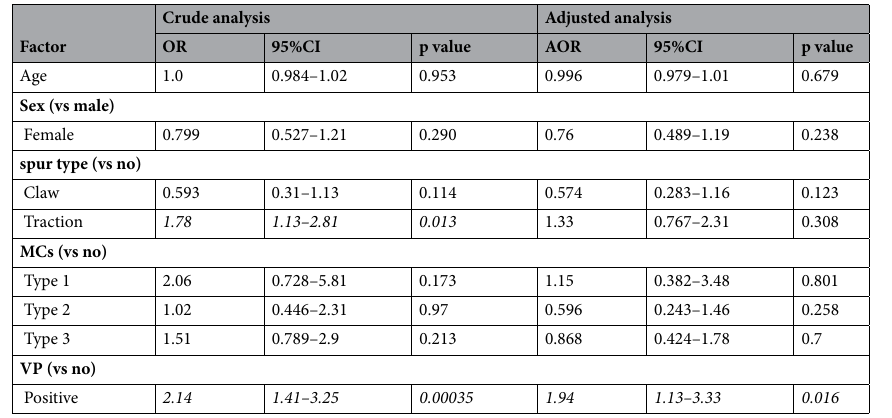
Table 4. Associations of traction spur, Modic changes, vacuum phenomenon with prevalence of ΔADH > 3 mm. The crude analysis used single-variate logistic regressions whereas the adjusted analysis used multivariate logistic regression including all explanatory variables. ADH, anterior disc height; MCs, Modic changes; VP, vacuum phenomenon; OR, odds ratio; AOR, adjusted odds ratio. Significant values are in italics.